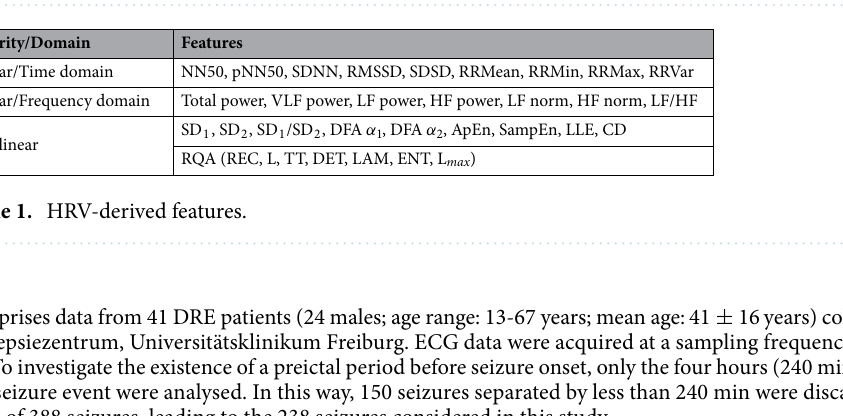
Figure 1. Block diagram of the proposed methodology.